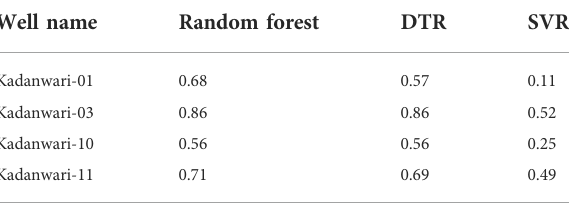
TABLE 5 Values of R 2 between predicted and measured DTS curves.